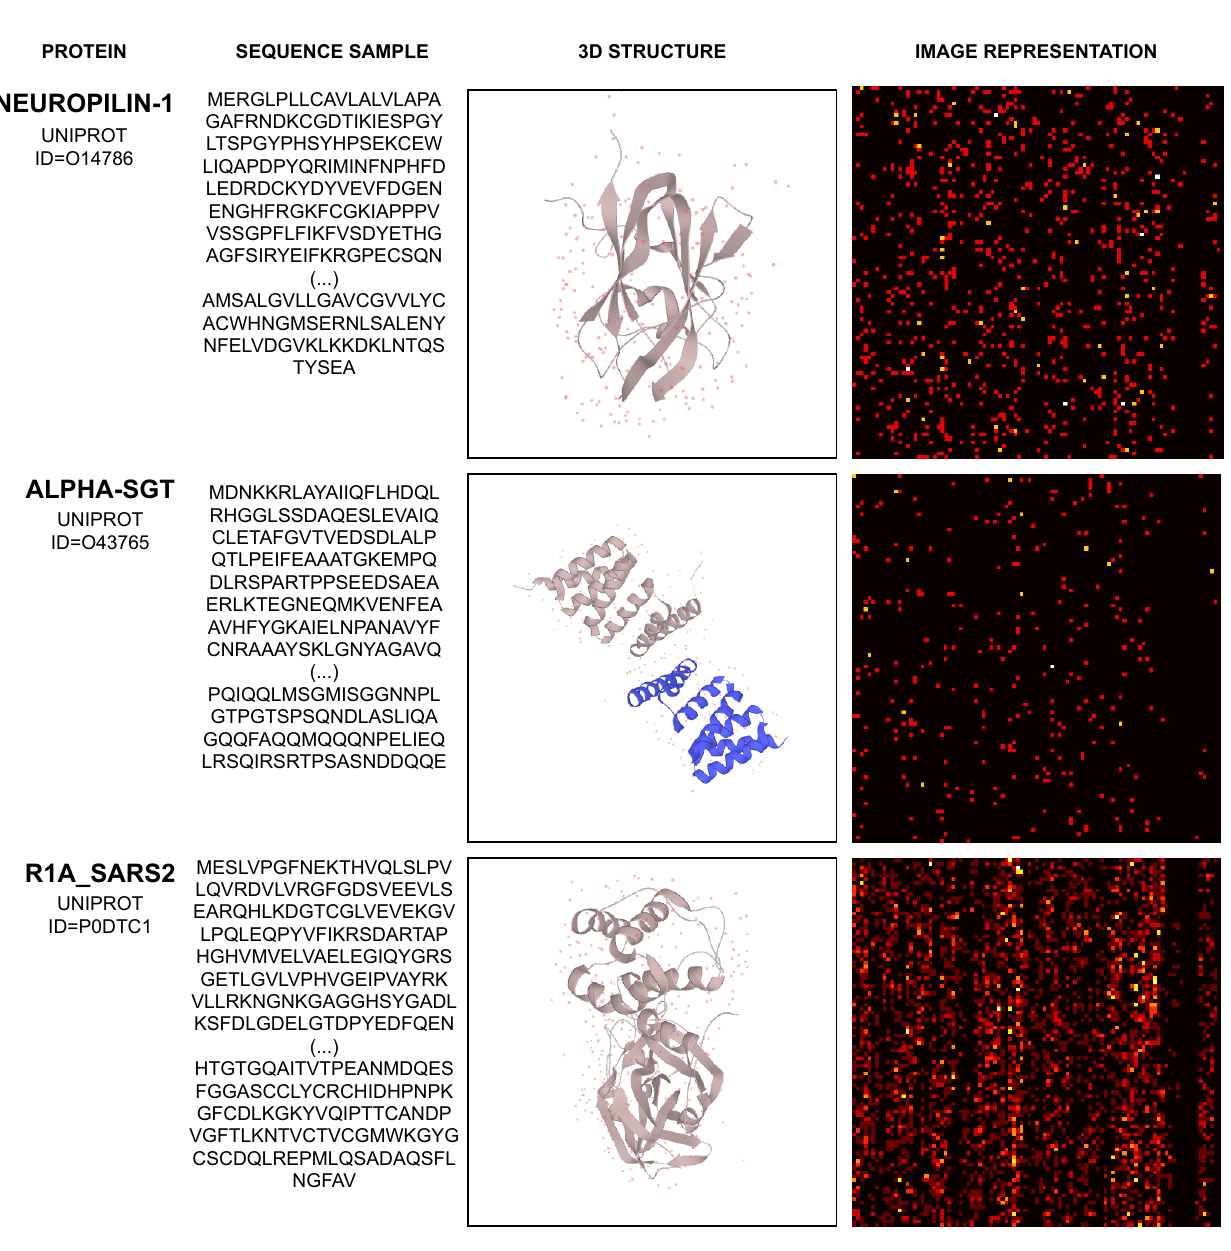
Figure 5. Example of mapping protein sequence to image. The proteins depicted by Figure 5 and their corresponding UNIPROT IDs are Neuropilin-1 (O14786), Alpha-SGT (O43765), and R1_SARS2 (P0DTC1). Their amino acid sequence and 3D structure’s visual representation are obtained from